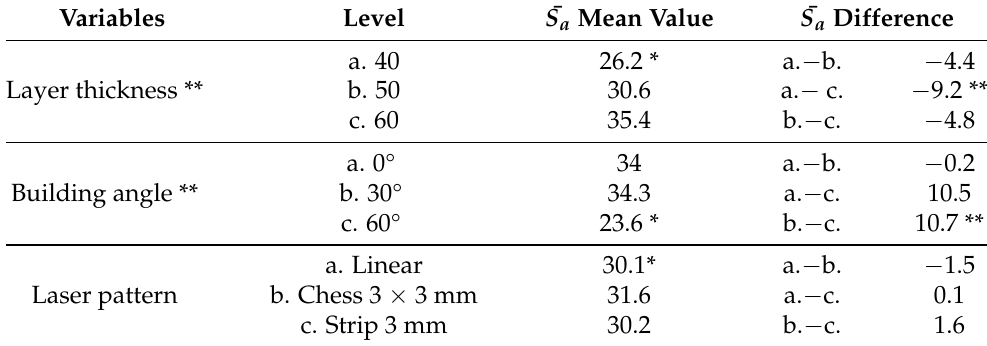
Table 9. Optimum conditions and main variables for blue surface ( BS ): S a mean value for each level of variables ( − 1, 0,